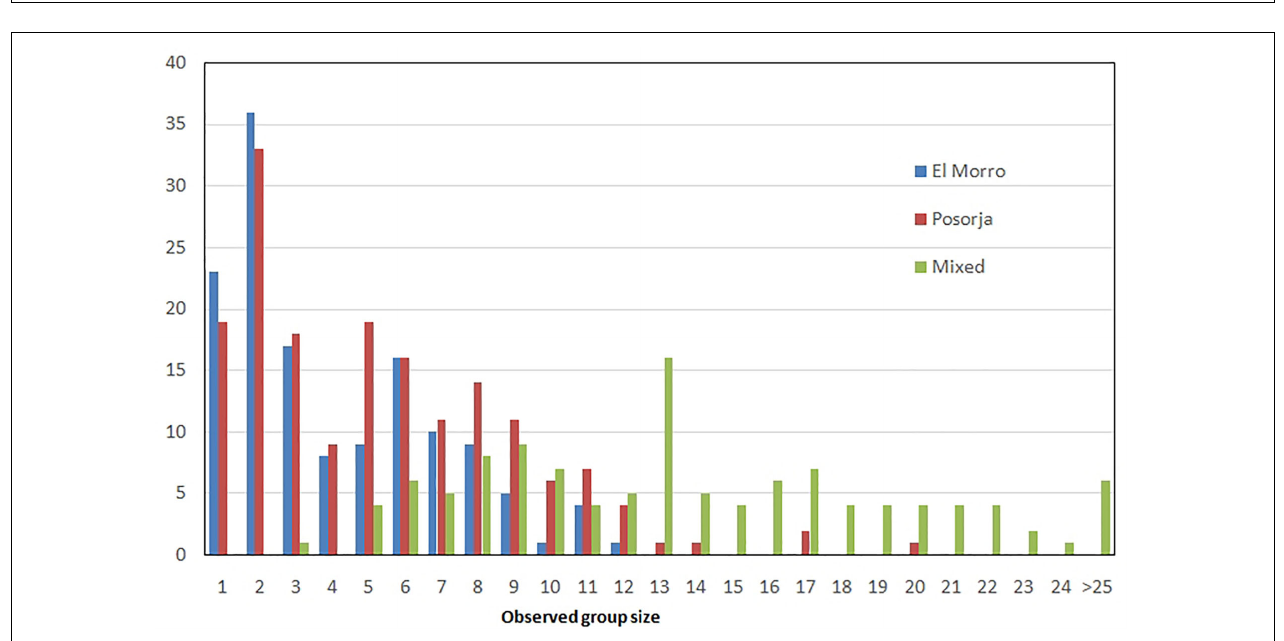
FIGURE 3 | Group size frequency distribution in each dolphin community and mixed groups.